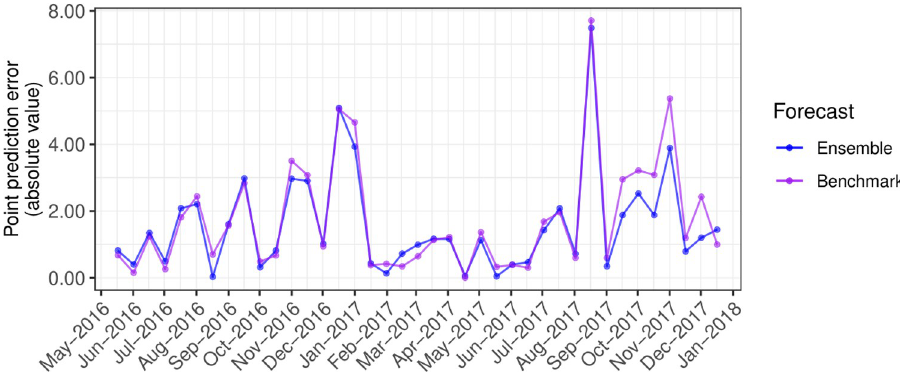
Fig 5. Out-of-sample point prediction errors for the ensemble and ETS benchmark